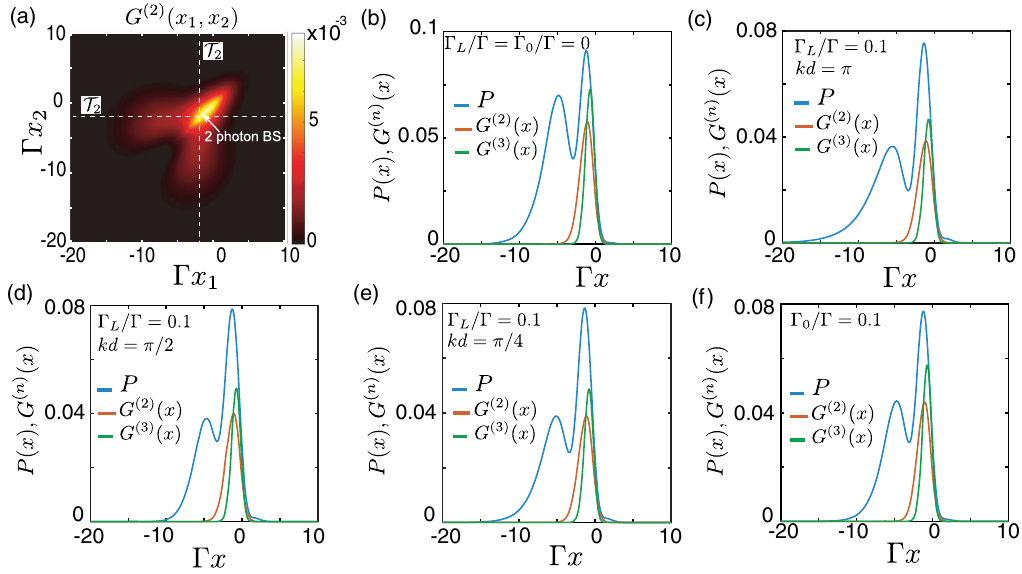
FIG. 5. Propagation of a coherent pulse with average photon number ¯ n ¼ 0 . 5 through N ¼ 2 emitters. (a) Two-time correlation ffiffiffi p 2 function G ð 2 Þ ð x 1 ; x 2 Þ for pulse width Γ σ ¼ 3 for ideal chiral coupling computed using the three-photon theory. Dashed lines show N times the Wigner delay of the two-photon bound state τ 2 . (b) Power P ð x Þ and second- and third-order correlation functions G ð 2 Þ ð x Þ and ffiffiffi p 2 G ð 3 Þ ð x Þ for pulse width Γ σ ¼ with ideal coupling. Power and correlations when also coupling to a backward mode with rate Γ 0 . 1 Γ where the emitters are separated by (c) kd ¼ π , (d) kd ¼ π = 2 , and (e) kd ¼ π = 4 . (f) Power and correlation functions for L ¼ unidirectional coupling, but with each emitter also coupled to a loss mode with Γ 0 ¼ 0 . 1 Γ . Panels (b) – (f) are computed using a full numerical